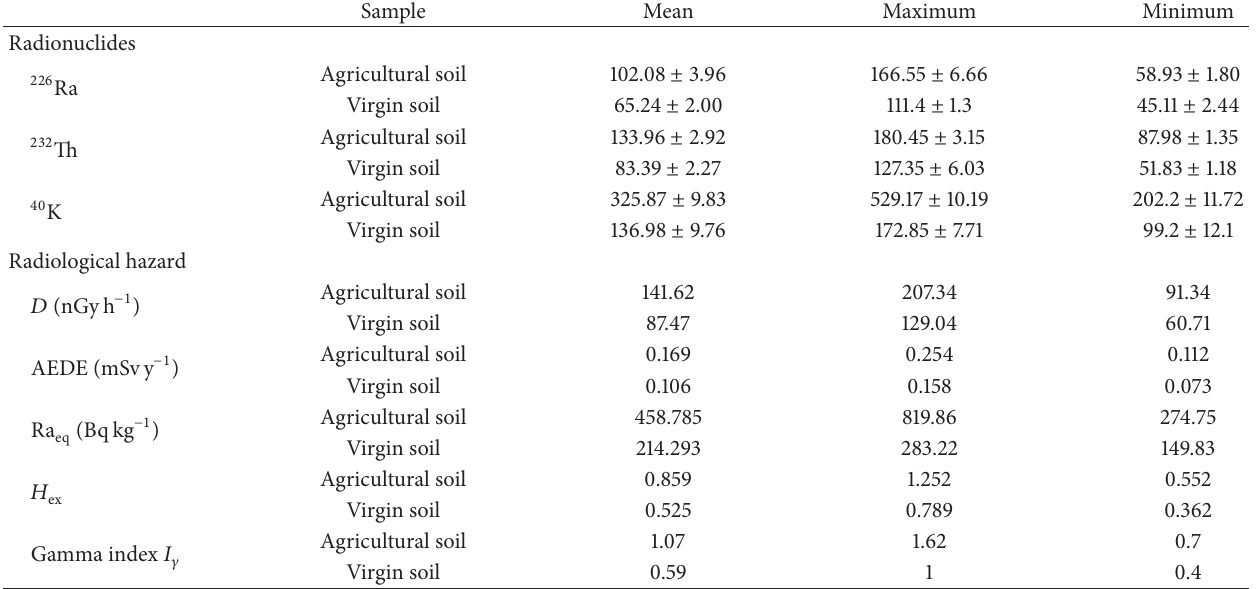
Table 5: Range and mean value of activity concentrations of 226 Ra, 232 Th, and 40 K (in Bqkg −1 ), Ra equivalent Ra eq (Bqkg −1 ), absorbed dose